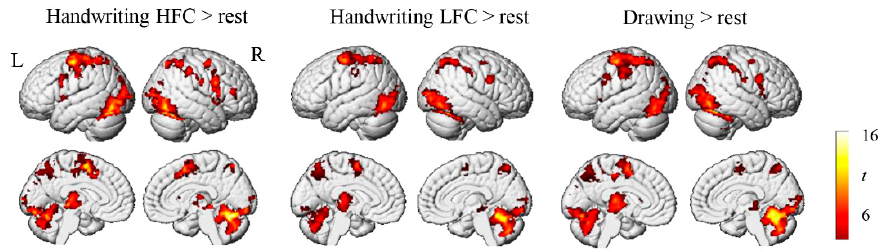
Figure 2. Brain activation during handwriting and drawing. HFC = high-frequency character, LFC = low-frequency character, L = left, R = right.